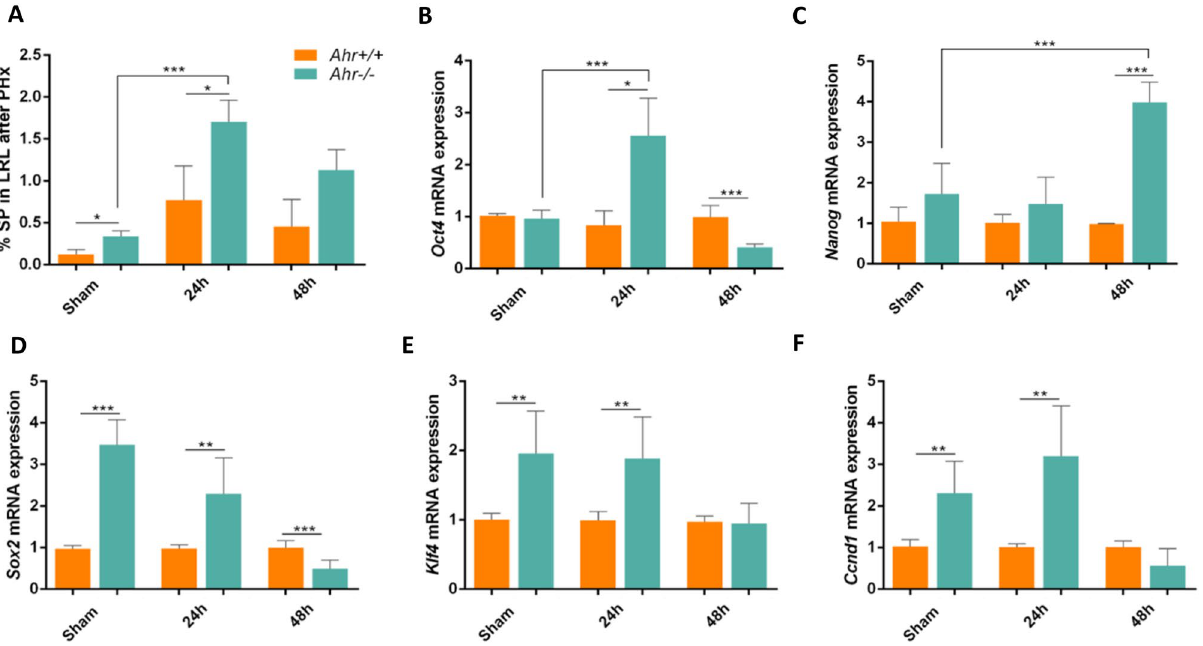
Figure 6. Lack of Ahr expands the side population and upregulates pluripotency markers in the regenerating liver. ( A ) Lateral right lobes of the liver were obtained from of Ahr + / + and Ahr −/− mice at the indicated points after PHx. Samples were processed to isolate and quantify side population cells (SP) by cell sorting. SP + cells are expressed with respect to the total number of liver cells. ( B – F ) mRNA was purified from SP + cells of both genotypes and used to analyze by RT-qPCR the expression of Oct4 ( B ), Nanog ( C ), Sox2 ( D ), Klf4 ( E ) and Ccnd1 ( F ). Gapdh was used to normalize target gene expression (ΔCt) and 2 −ΔΔCt to calculate changes in mRNA levels with respect to wild-type mice. *p < 0.05, **p < 0.01, ***p < 0.001. Data are shown as mean ± SD. The experiments were performed using three mice per time point and three technical replicates were done. Oligonucleotides used are indicated in Supplementary Table